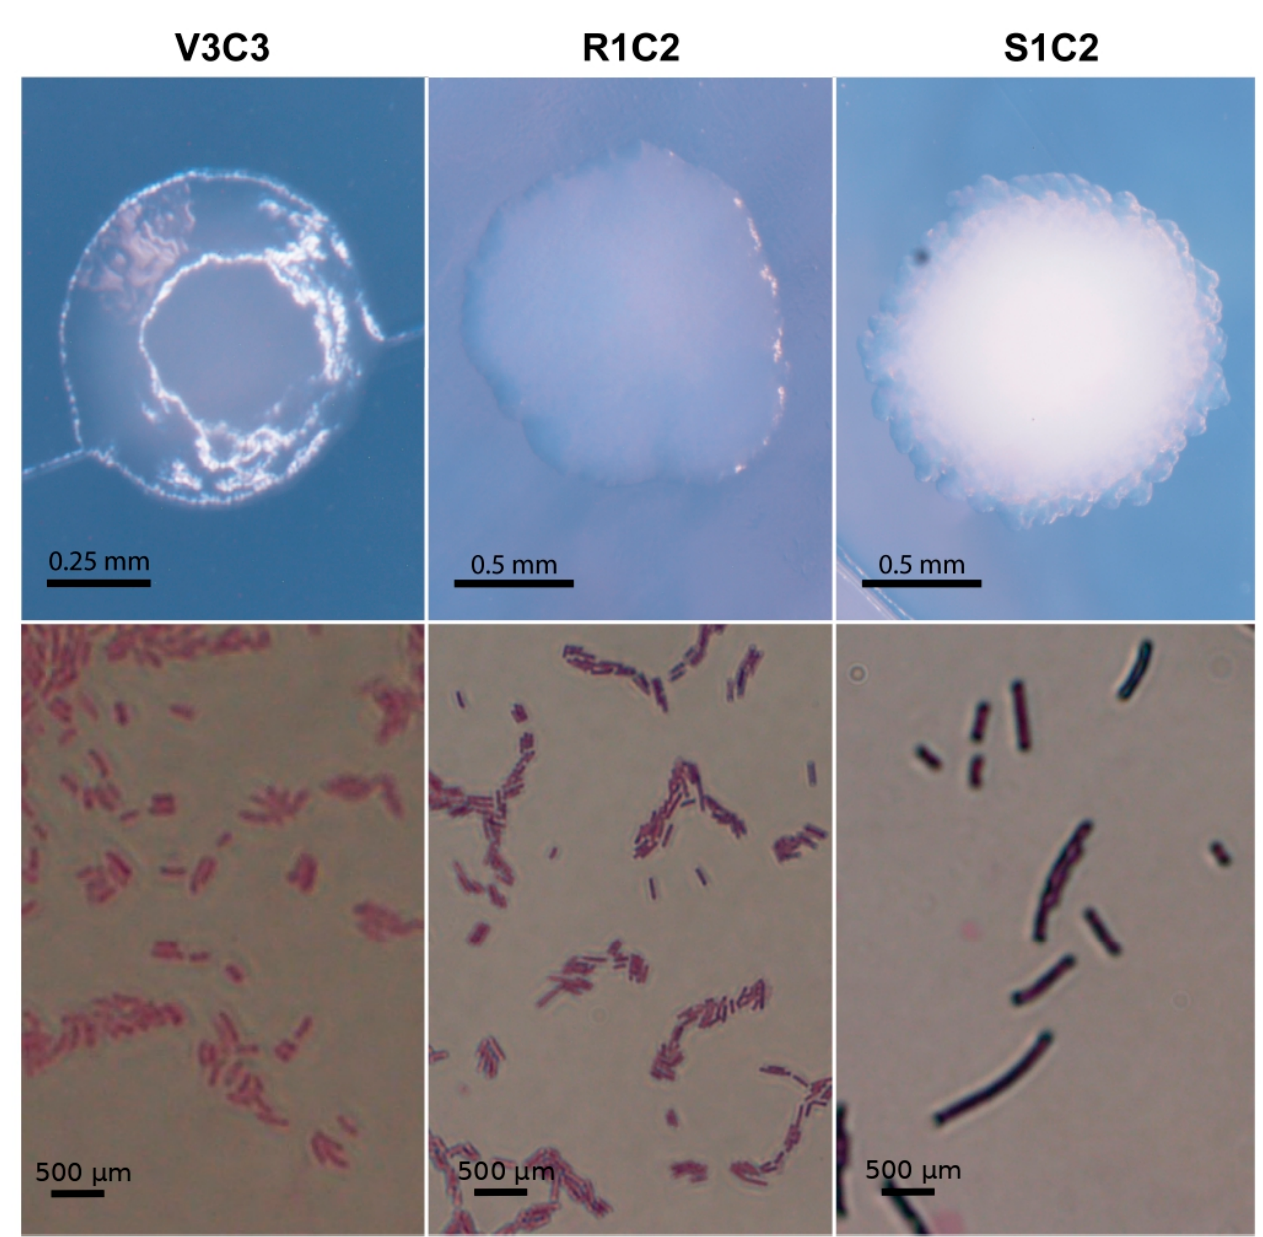
Figure 1. Morphological characterization of hypertolerant bacteria (HCdB). Above: Bacterial colonies photographs got by Nikon SMZ18 stereoscope coupled to DS-Ri2 camera. Below: Bacterial Gram stain microscopy got by Olympus DP74 microscope at 100 × . Pictures in the same column belong to the strain indicated on the top. Table 1. Phenotypic characterization of cadmium-resistant bacteria associated with cacao .